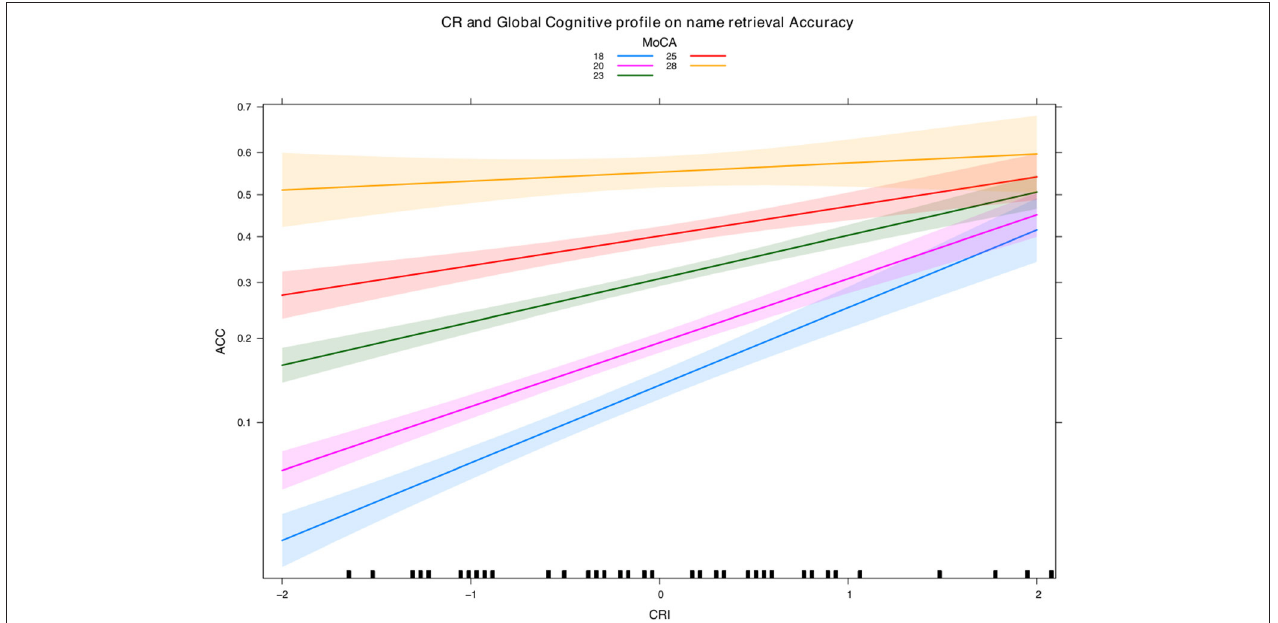
FIGURE 3 | CRI and MoCA as predictors of name retrieval Accuracy in older adults. Generalized Linear Mixed Models; MoCA, Montreal Cognitive Assessment; ACC, Accuracy; CRI, Cognitive Reserve Index.